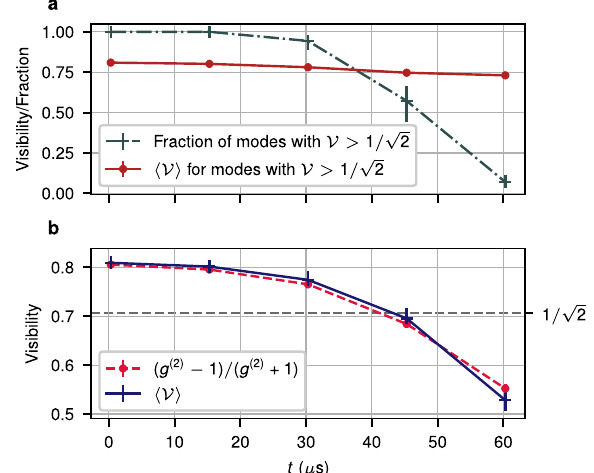
Fig. 3 Evolution of visibility among many modes. Figure presents Bell state visibility V ð x s ; y s ; t Þ retrieved from coincidences patterns measured with a quickly changing linear MZI phase φ ( k ) ∝ y r ∝ y s . Presented data covers a selected range of observed wavevectors and subsequently larger memory storage times t . a – e Experimental data. f – j Visibility model best fi t. Hatched regions correspond to visibility V > 1 = Experimental data and model fi ts are averaged over four combinations of measurement ports ( s r , s w ) = {( + , + ), ( + , − ), ( − , + ), ( − , − )}. Before model fi tting, experimental data is Gaussian fi ltered to reduce noise. Some of the raw data is also presented in Supplementary Material Sec. S5. ffiffiffiffiffiffiffiffiffiffiffiffiffiffiffiffiffiffi